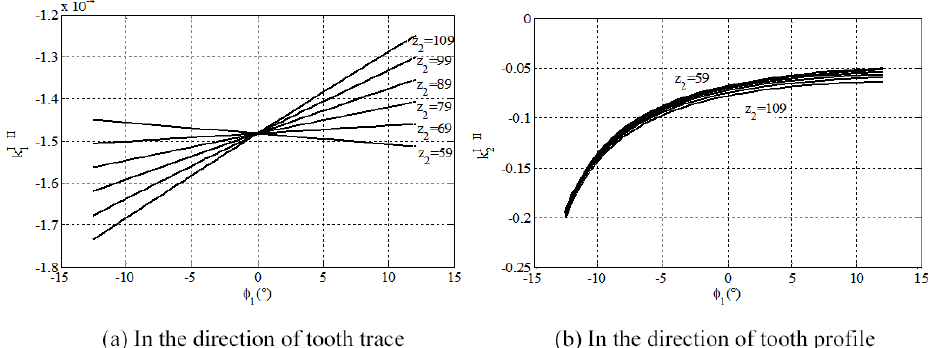
Figure 8. Effect of tooth number of the driven gear on induced normal